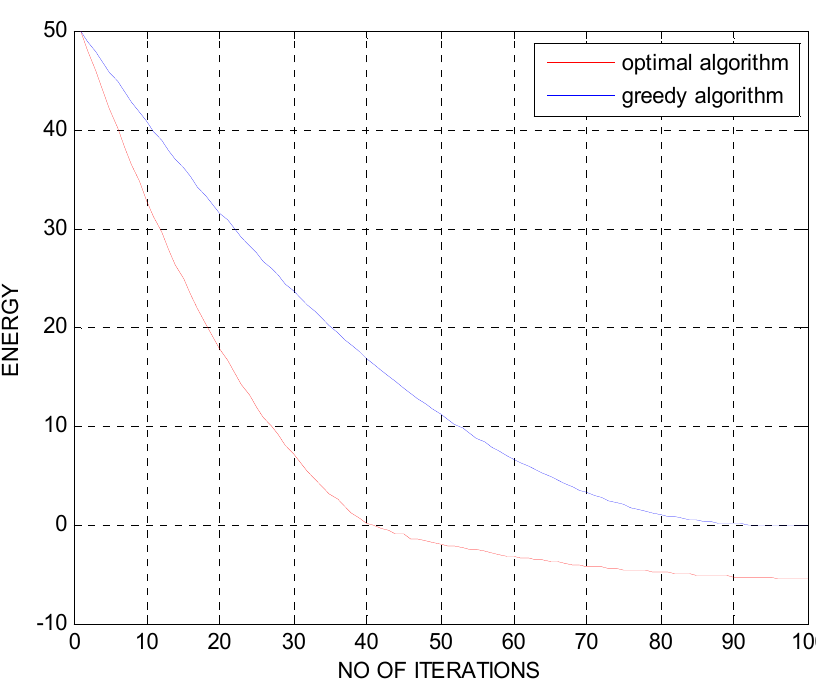
Figure 6. Number of iterations vs. energy (bits/J).